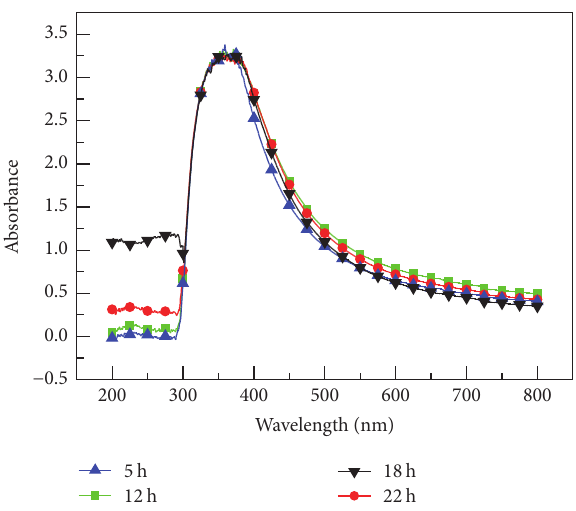
Figure 6: Absorption spectra of TiO 2 photoelectrodes based on P25/TNT arrays double-layer films at different anodization time.